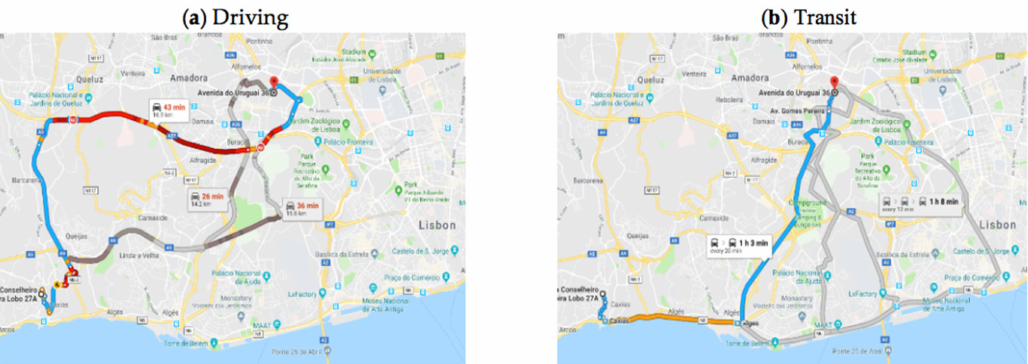
Figure 1. Examples of possible route choices by ( a ) driving and ( b ) public transit, from the use of the Google Maps Directions API.